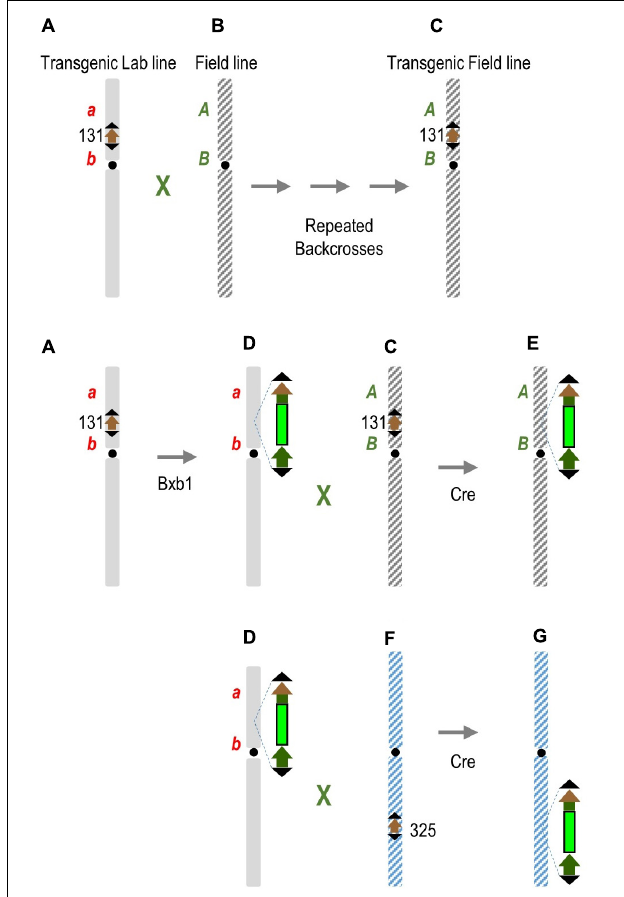
FIGURE 4 | Cre-mediated transgene translocation to break linkage drag. (A) Transgenic lab line created by gene transfer, with or without a first transgene (not shown), is crossed repeatedly to a field line (B) to introgress the transgenic locus into transgenic field line (C) with the combination of elite traits. Subsequent stacking of additional transgenes to the same target site (D) can be crossed with the transgenic elite line (C) . Introduction of Cre recombinase translocates the new transgenic locus from lab line to field line at the same chromosome position (E) . Optionally, Cre translocates the transgenic locus in line (D) to a different chromosome (F) with a target locus introgressed into a field line (G) , which might be necessary if the non-elite traits a and/or b are too close to the target locus and fail to segregate away. A , B represent elite traits; a , b non-elite